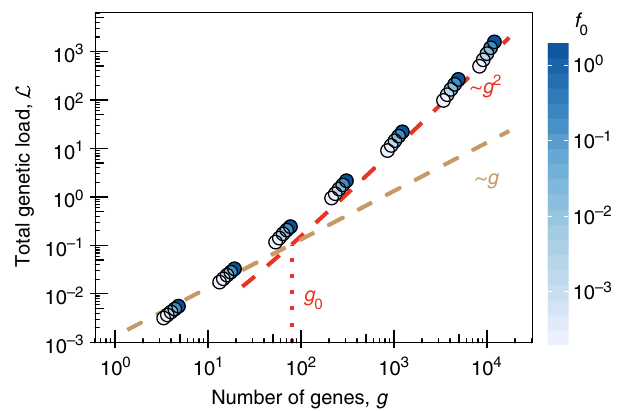
Fig. 3 Genetic load. Total genetic load L versus the number of genes g for asexual evolution for the minimal biophysical model at steady-state asexual evolution. Simulation results (circles) for different values of f 0 (indicated by color, as in Fig. 2); model results for independently evolving genes, L ¼ ug (brown dashed line), and phenotypic interference load, L dashed line); see Eq. 9. The superlinear behavior of L for g > g indicates strong selection against genome complexity. Other simulation parameters as in Fig. 2; see Methods section for simulation